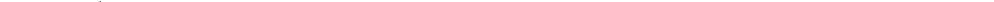
figure on next Fig. 2 The BR combination induces p-eIF2α-dependent apoptosis of mutant KRAS CRC cells. The indicated cells were treated with vehicle (Un, Untreated), Bortezomib (B), Everolimus (R), or the combination (BR, 5 nM and 10 µM). a Differential genes induced by BR in HCT116 cells at 24 h visualized by volcano plot. Upregulated (red) or downregulated (green) genes (fold change b Top 10 enriched non-overlapping pathways in upregulated genes (1231) identified by GO. c qRT-PCR analysis of the indicated markers at 24 h. d Western blotting of the indicated proteins at 24 h. Arrows indicate cleaved and active caspase. Actin was used as the loading control. e Attached cells at 48 h were visualized by crystal violet staining. f Apoptosis at 48 h was analyzed by nuclear fragmentation assay. g Cells were transfected with vector control (VC) or EIF2AS51A expression construct for 24 h, replated for 24 h, and treated by the BR combination for 48 h. Attached cells were visualized by crystal violet staining. h Western blotting of indicated proteins at 24 h. c and f, values are mean *** p < 0.001 (Student’s t -test, two tailed). B, R vs. BR, or WT vs.